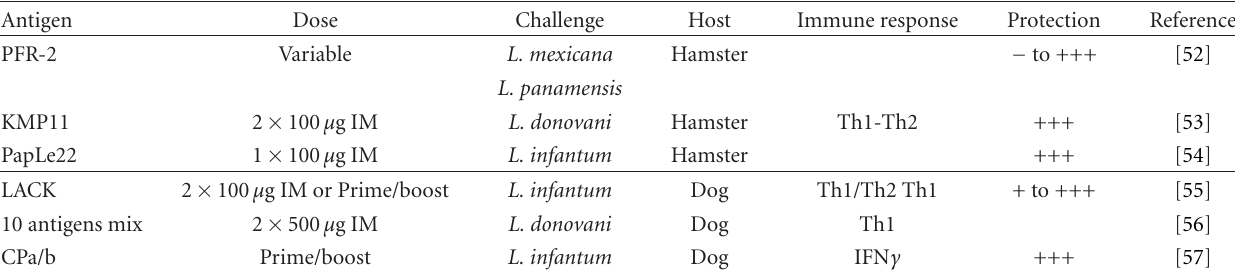
Table 2: Preclinical studies Leishmania DNA vaccines in nonmurine